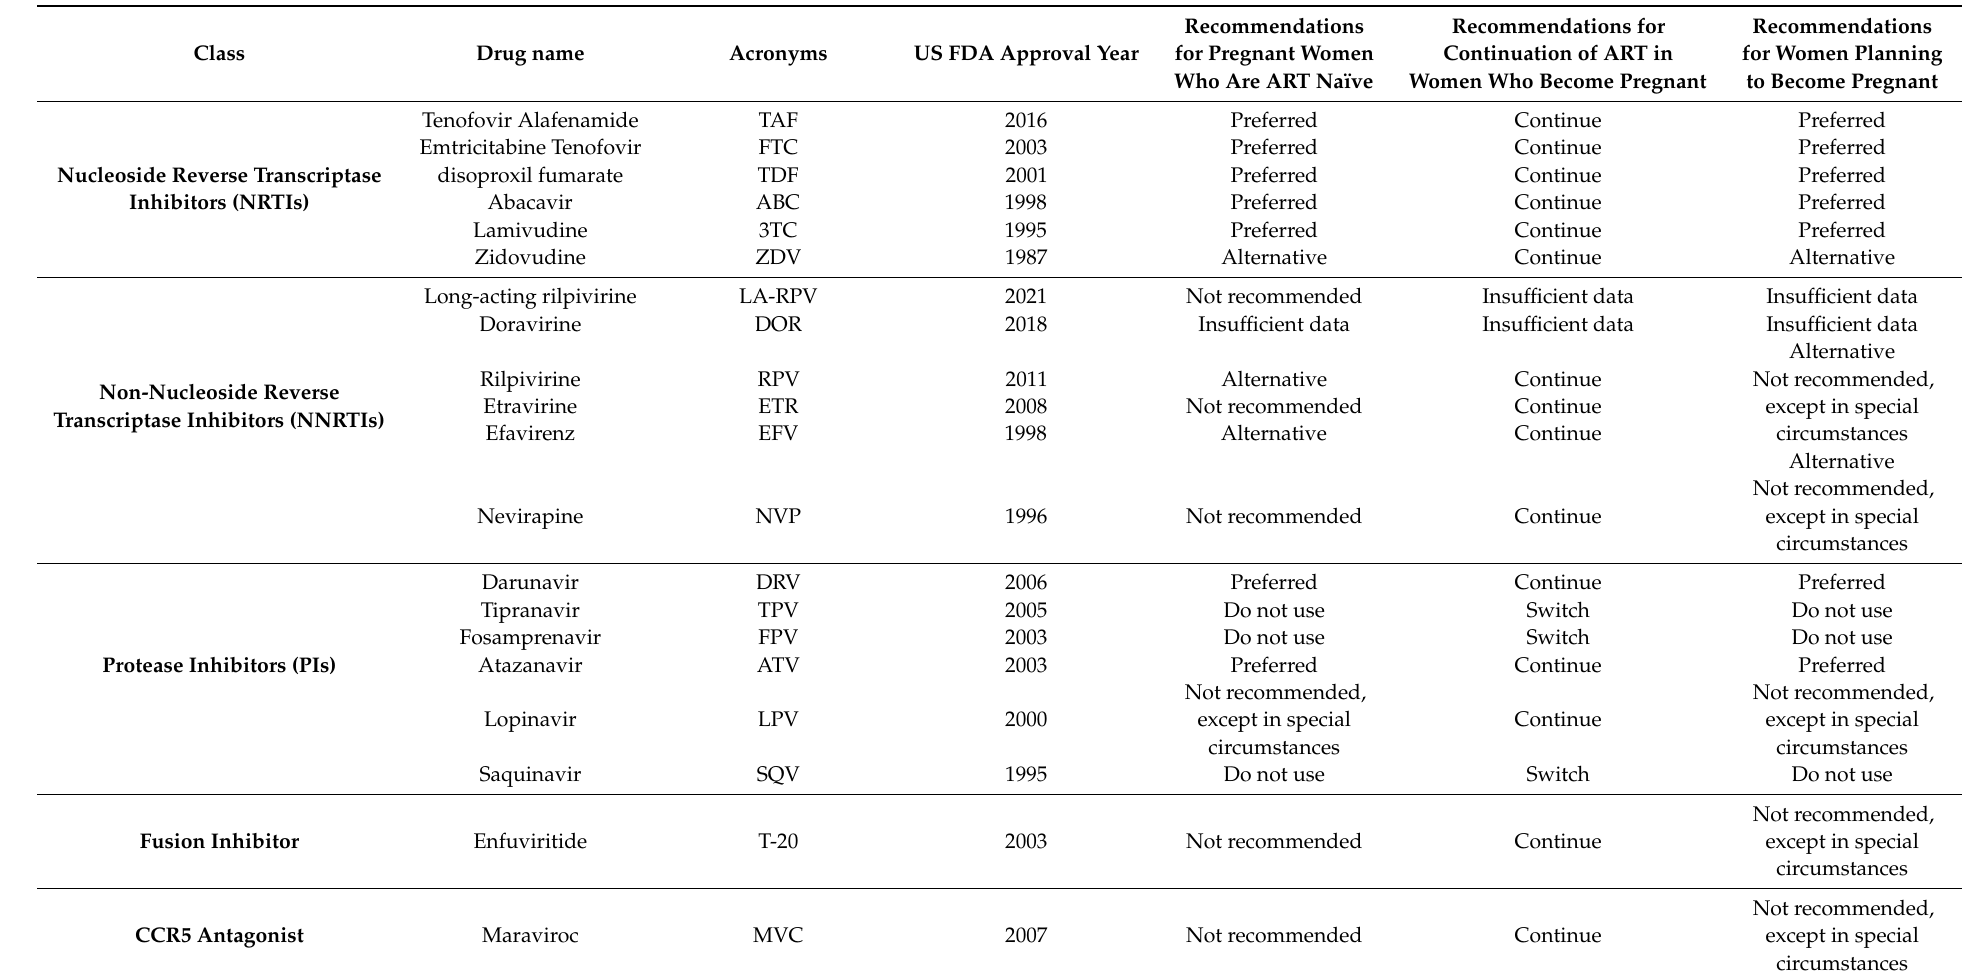
Table 1. Antiretrovirals (ARVs) and recommendations for their usage during